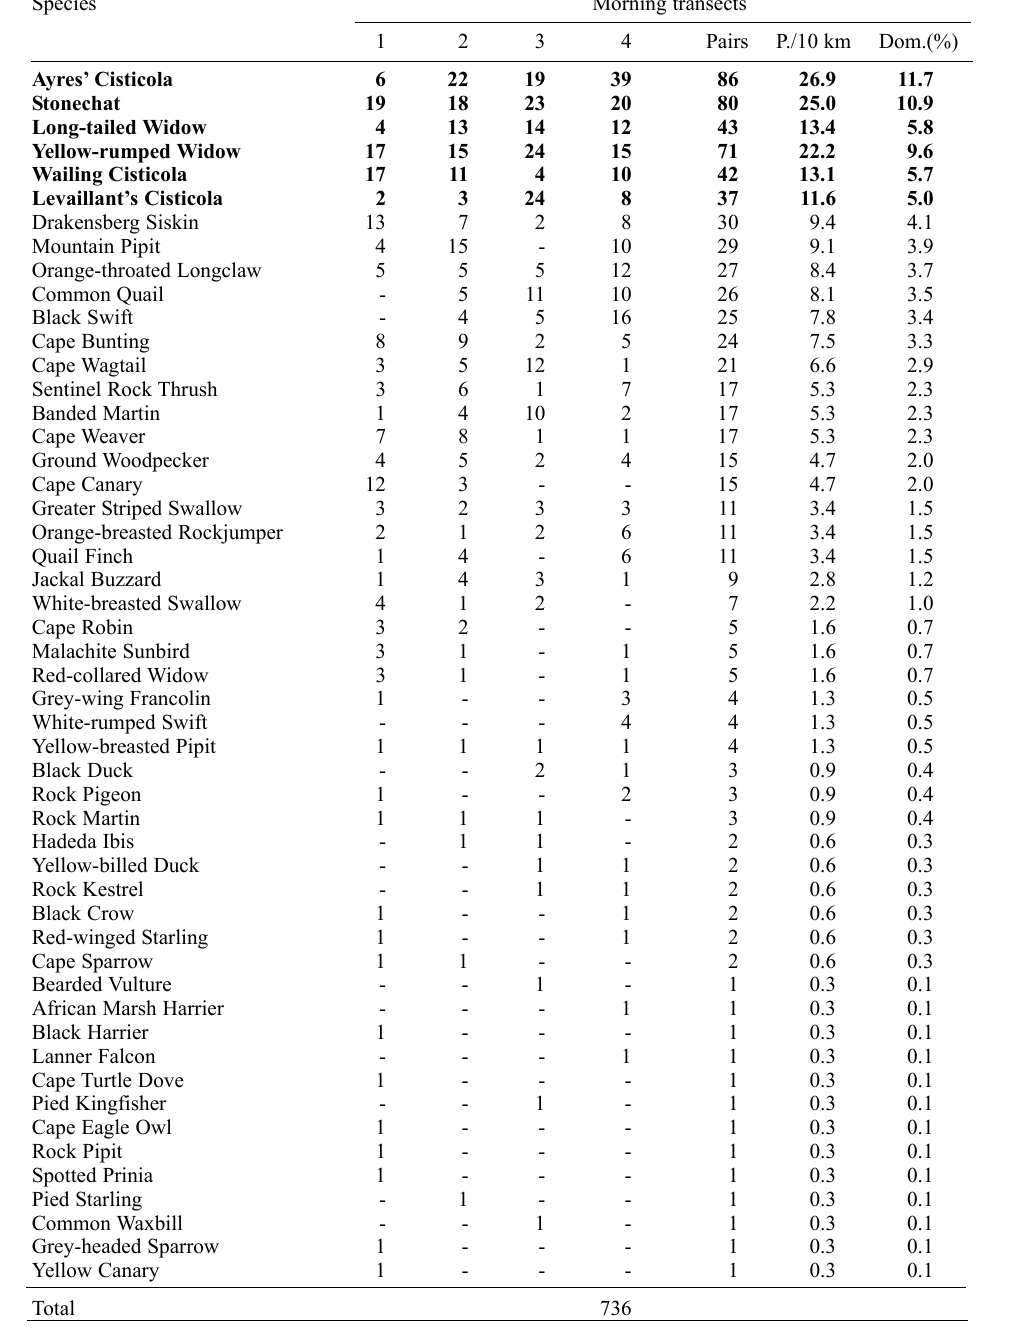
Breeding bird community of Afro-alpine Grassland in Sehlabathebe National Park in January 2001. Dominant species are given in bold case